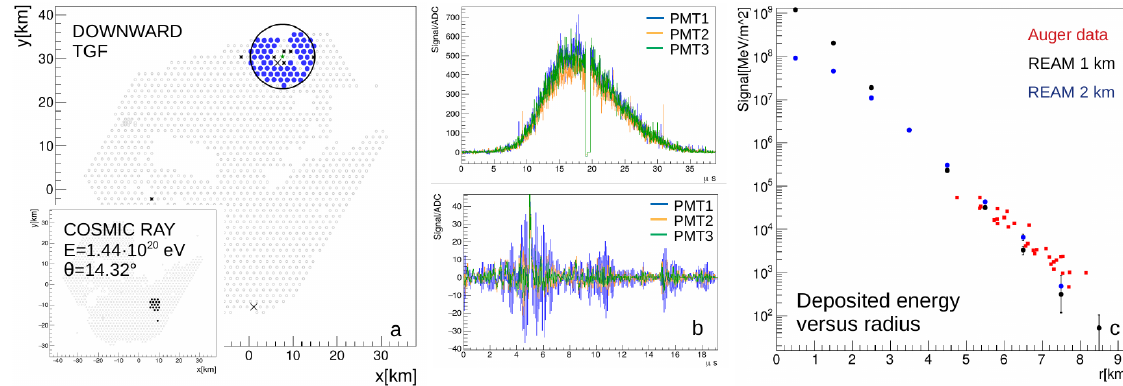
Figure 1. Panel “a” : the large footprint of a TGF-like event (blue dots) compared to the footprint of an extensive air shower (black dots). Panel “b” : the typical long signal of a TGF-like event is shown in the upper plot. This specific trace is the combination of the two long signals collected in two consecutive events. The time evolution of the TGF-like events is longer than that of a cosmic-ray shower. The lower plot shows the so-called lightning signal, whose presence in each TGF-like event suggested their correlation with lightning. Panel “c” : deposited energy at the ground as a function of the distance from the center of the footprint compared with the expectation for a standard downward